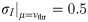
Match between theory and simulations in the input-output gain function of LIF neurons.Gain functions Φ for N = 4000 LIF neurons (uncoupled and coupled), obtained by varying the total mean current μ = μI + τmIext/Cm for different τs and different size σI of the synaptic current fluctuations: (A) σI|μ=vthr=0.5 mV and (B) σI|μ=vthr=2.0 mV. In the explored range of μ, σI varies between 74% and 138% of its value at μ = vthr. Left panels in (A-B): theoretical Φ0 from 0-th order approximation (τs = 0, gray dashed curves) and measured Φτs for τs ∈ {0, 1, 4, 16} ms (reddish curves) from single-neuron simulations. Central and right panels in (A-B) show the differences ΔΦ=Φτs-Φ0, either including (right) or excluding (middle) an additional unfiltered white noise with σext=σI|μ=vthr. Only the three curves with τs > 0 are shown as the simulations with τs = 0 largely overlap the x-axis due to the remarkable agreement with the theoretical Φ0. (C) Gain functions Φτs
versus the mean external current μext for a network of excitatory neurons. Network topology and neuron parameters as in Panel (B) with σext = 2.0 mV, but with 50% of recurrent synapses (the others receive Poissonian spike trains as in (B)). Thick arrows: values of μext = {15.2, 17.5, 20.5} mV driving the network from noise- to drift-dominated regimes, respectively. Bottom panel, steady-state firing rates (fulfilling the equilibrium condition Φ0(ν*) = ν*) of the network with non-instantaneous synaptic transmission (blue plots) and distribution of axonal delays (red plots) at the highlighted μext. Shaded strips in all panels: mean ± SEM from 10 independent simulations (see Methods for further details and parameters).